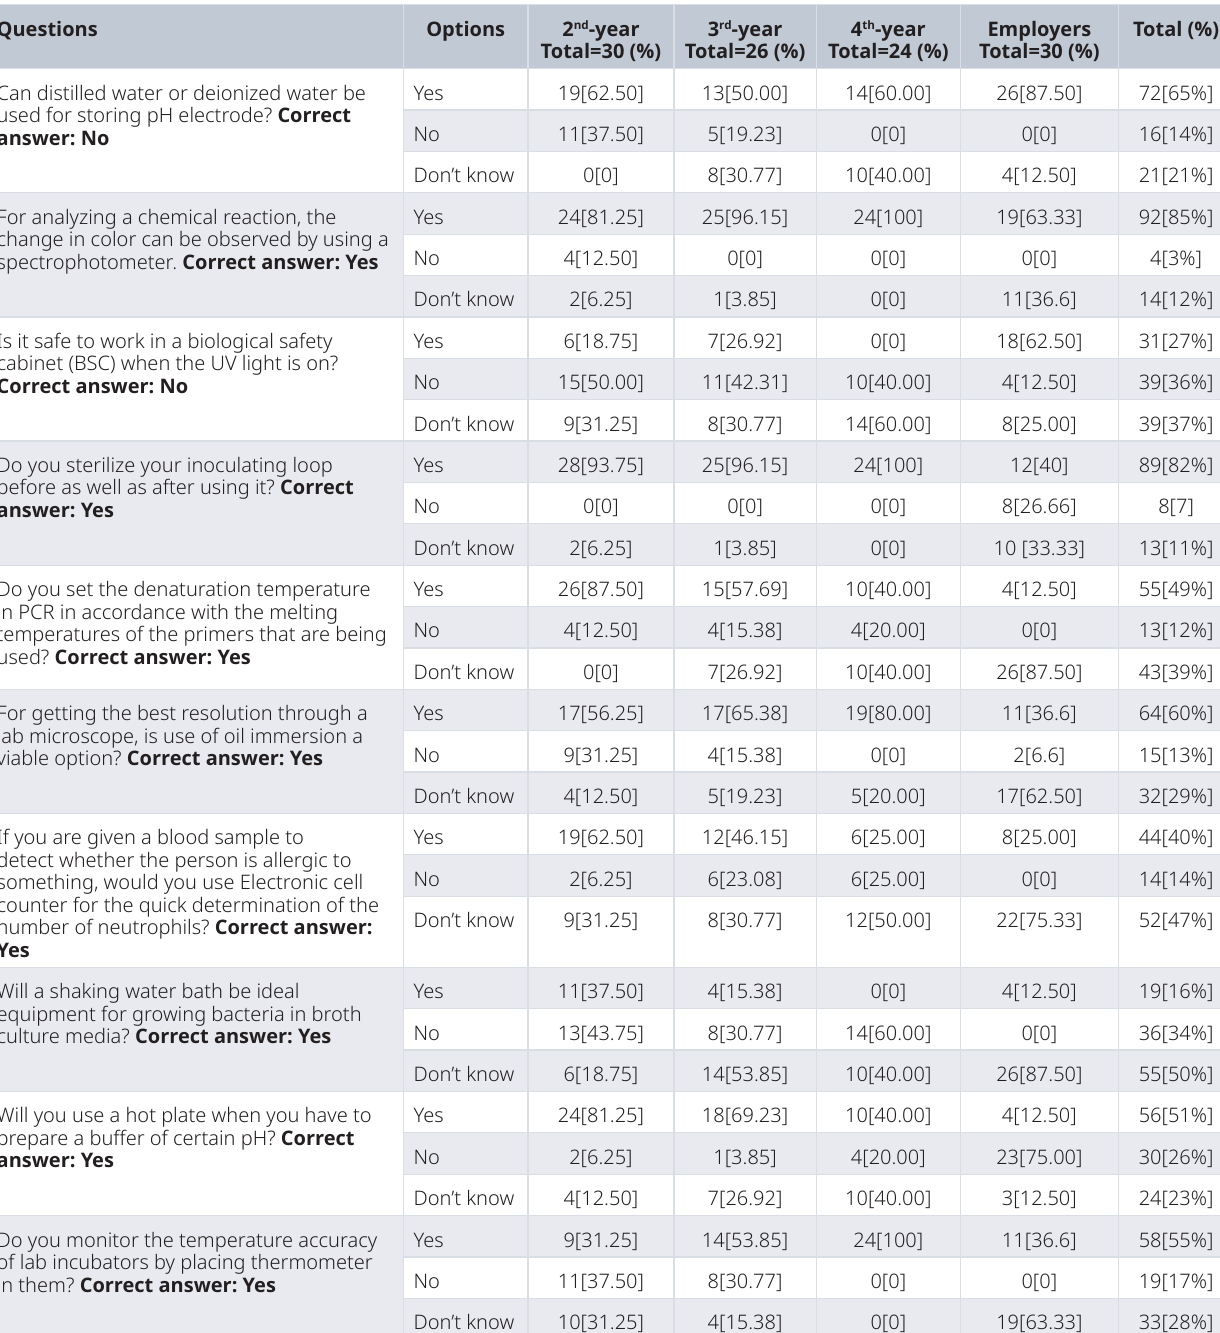
Table 2. Participant’ practice while using microbiology laboratory